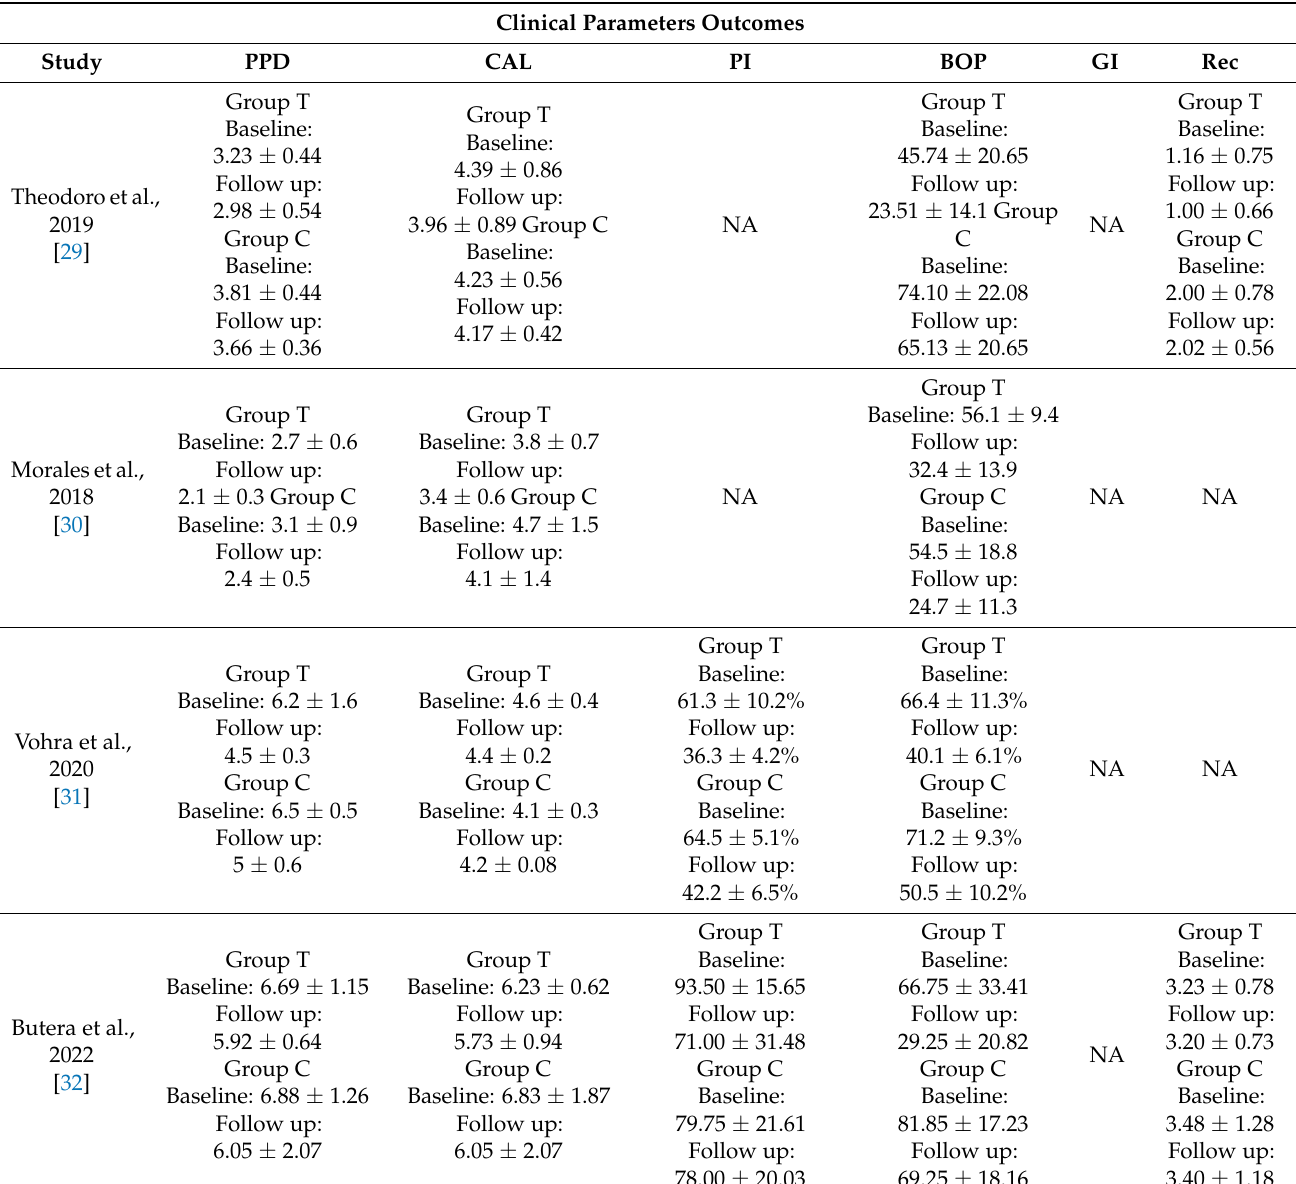
Table 3. Cont. Clinical Parameters